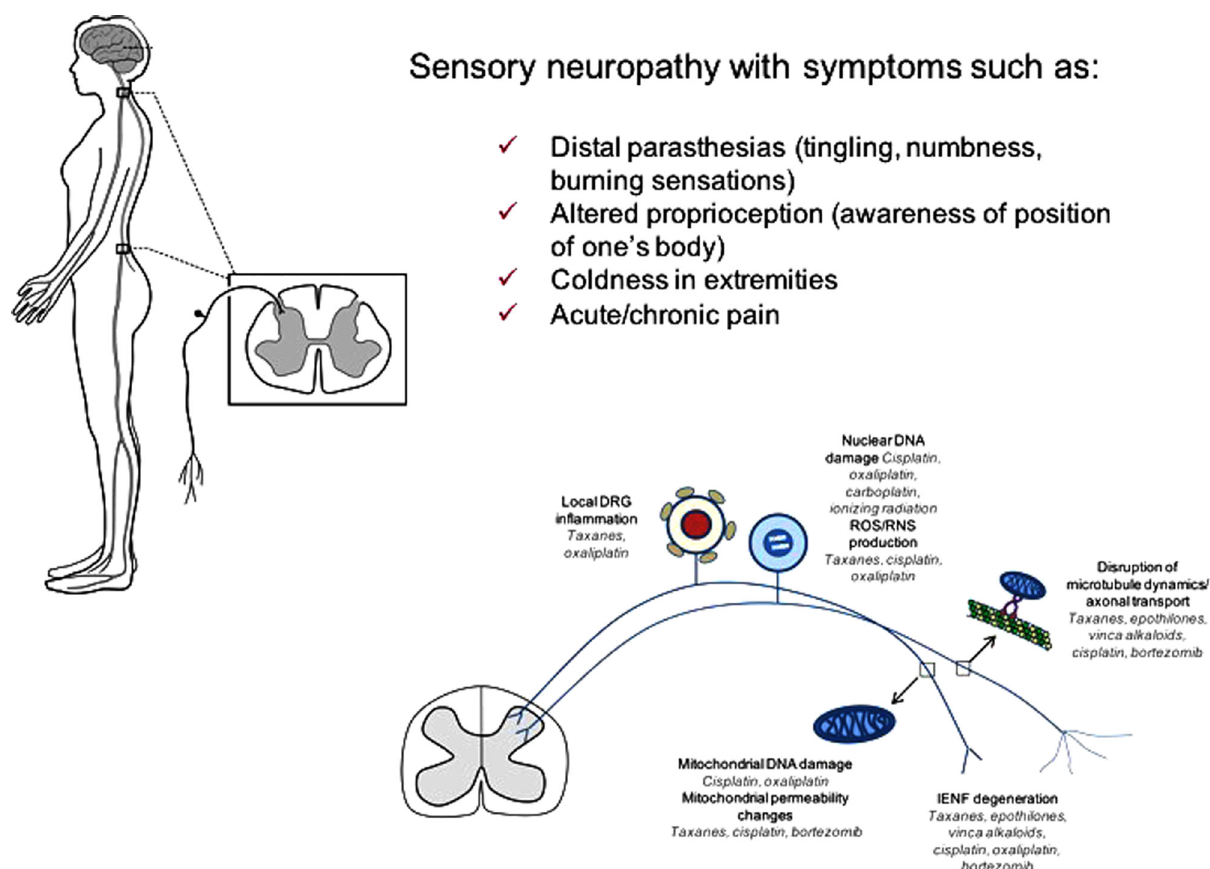
Fig. 5 Chemotherapy-induced peripheral neuropathy (CIPN) produces signi fi cant DNA damage acted upon by Ref-1/APE1. Agents inducing oxidative DNA damage, such as cisplatin, oxaliplatin, ionizing radiation as well as other drugs are acted upon by the DNA BER pathway and speci fi cally Ref-1/APE1. ROS reactive oxygen species, RNS reactive nitrogen species. DNA damage can occur on both nuclear and mitochondrial DNA in the dorsal root ganglion (DRG). Additional sites of action for some of the chemo-agents occurs in the axons. In fl ammation has also been attributed to inducing oxidative DNA damage in DRGs. Patients report side effects, such as severe burning in fi ngertips, like putting fi ngers on hot stove, fi ngernails on a chalkboard, pain like needle stuck in toes, walking on hot coals, sandpaper at the bottom of feet, something crawling, blob of numbness, and feet are asleep. Parts of this fi gure are used by permission from previous fi gures after revision (see refs. 252,